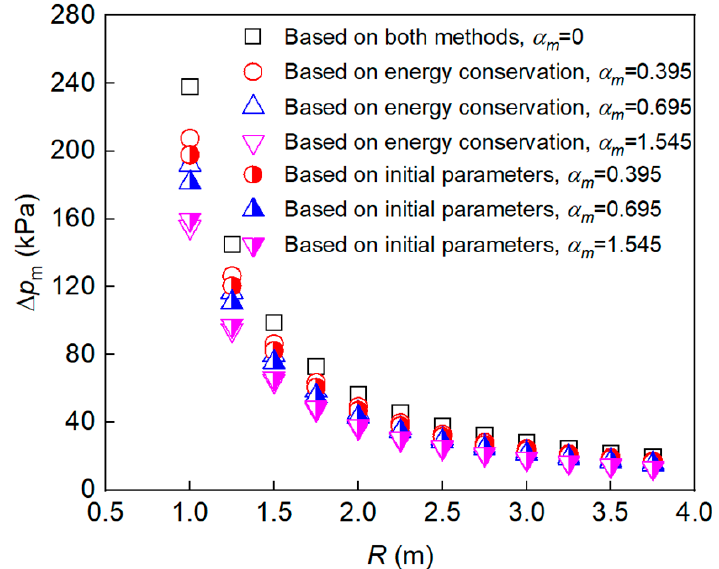
Figure 4. Calculations of peak overpressure for charges with different distances (the prediction results of the two methods are consistent at α m = 0).